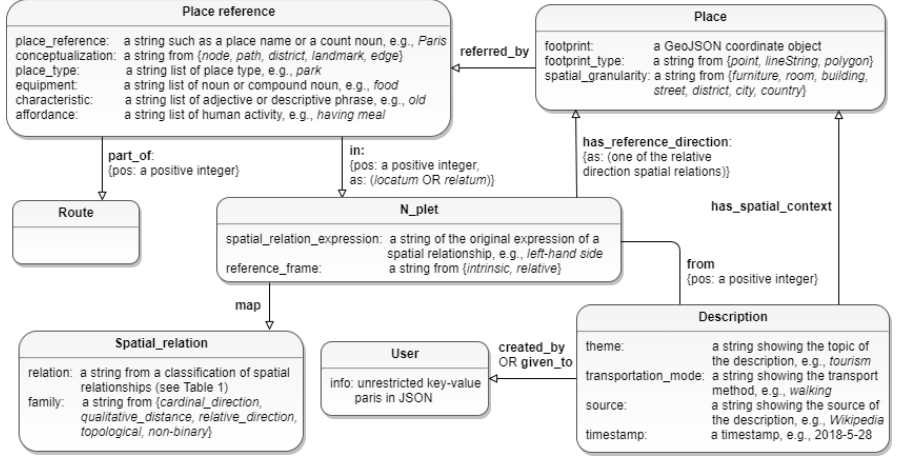
Figure 4. UML diagram illustrating the extended place graph database model, with seven types of classes (nodes) and nine types of relationships